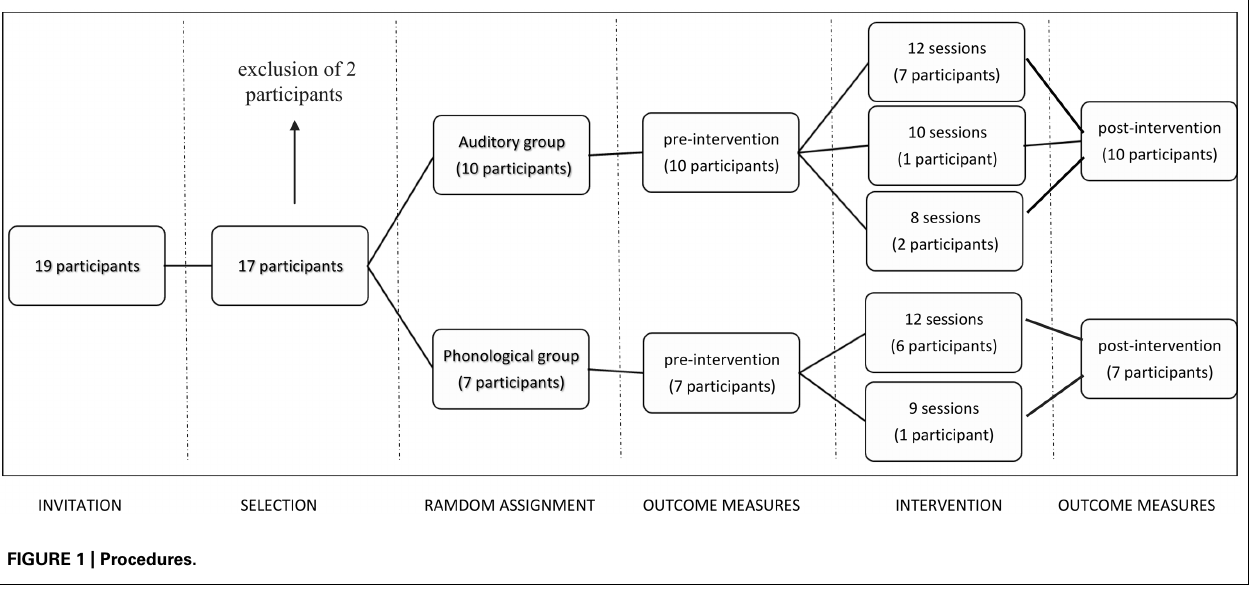
Table 2 | Comparison pre and post-intervention period (Intra-group